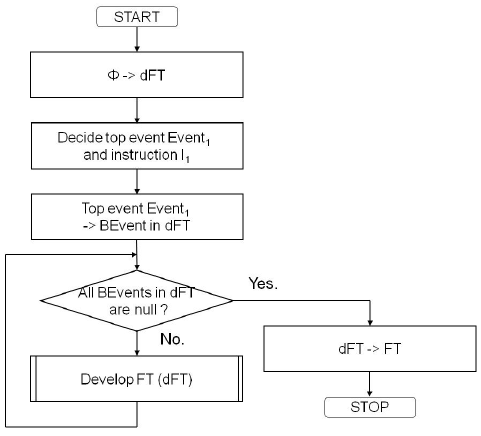
Figure 13. FT development rules -overview.